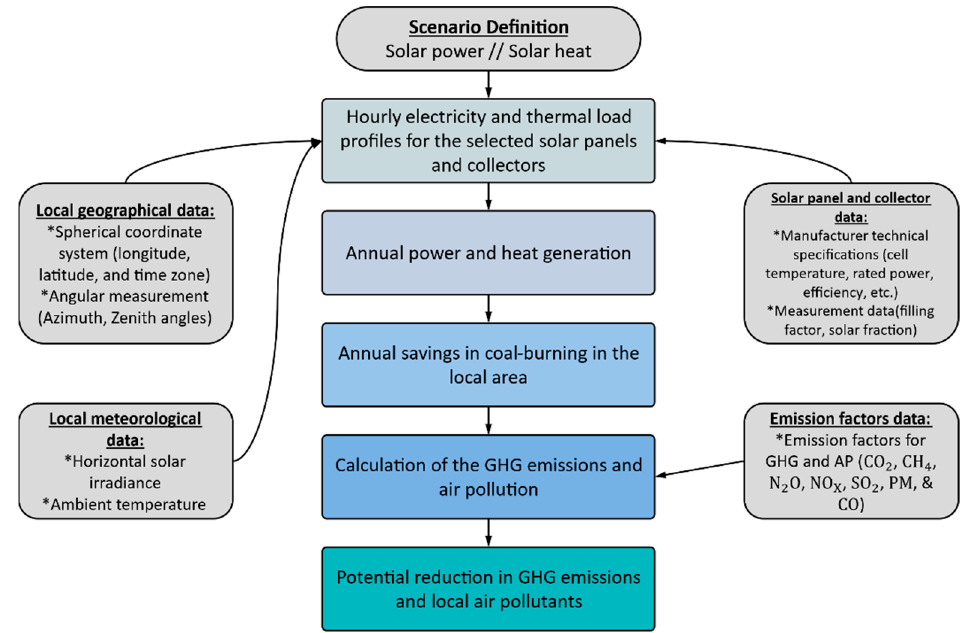
Figure 3. Calculation flow in the assessment of the environmental benefits (Created by the authors).